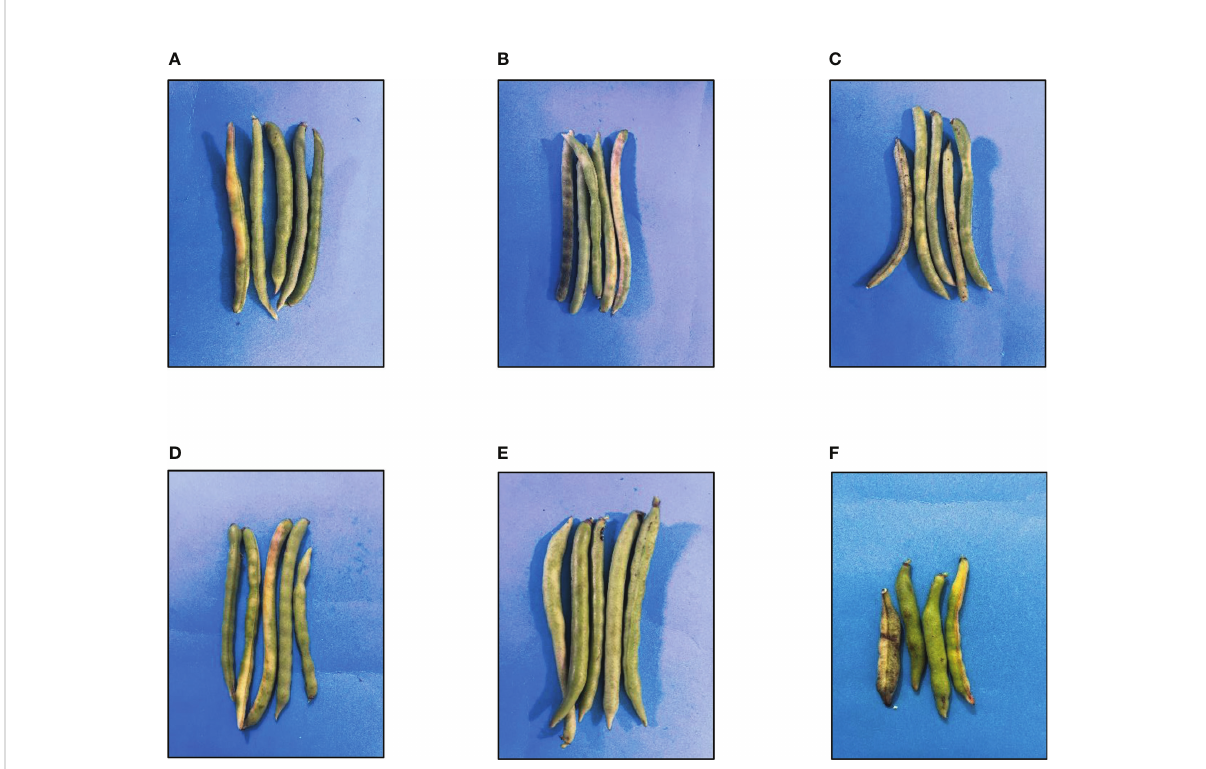
FIGURE 10 Effects of different GO NPs treatments on pod size of mungbean plants. (A) = C= without GO NPs application (control); (B) = T1= 300 mg/L; (C) = T2= 600 mg/L; (D) = T3= 900 mg/L; (E) = T4= 1200 mg/L; (F) = T5= 1500